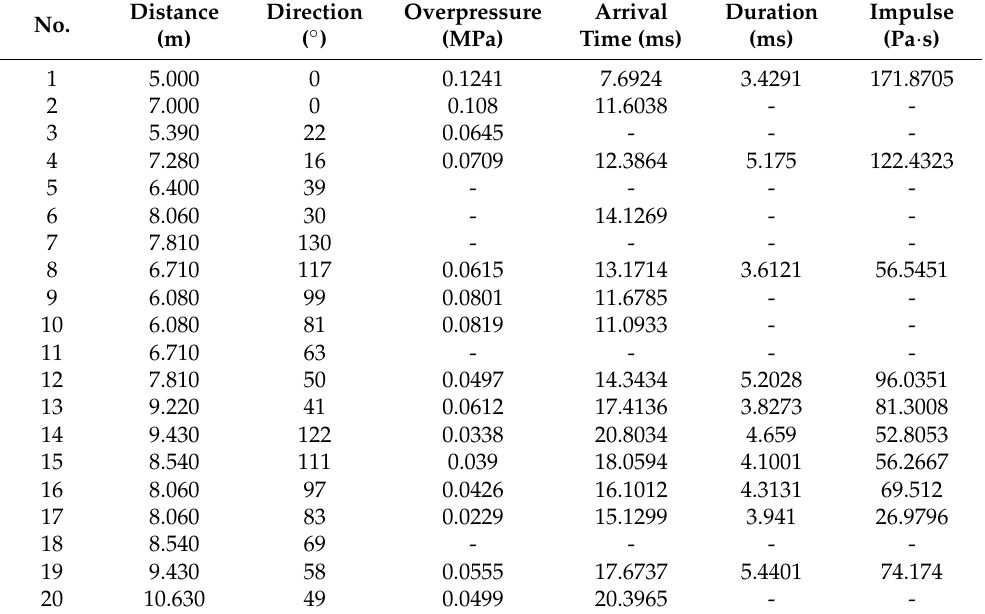
Table A4. Shock wave parameters of a moving charge explosion experiment ( V = 717 m/s, x = +1 m).